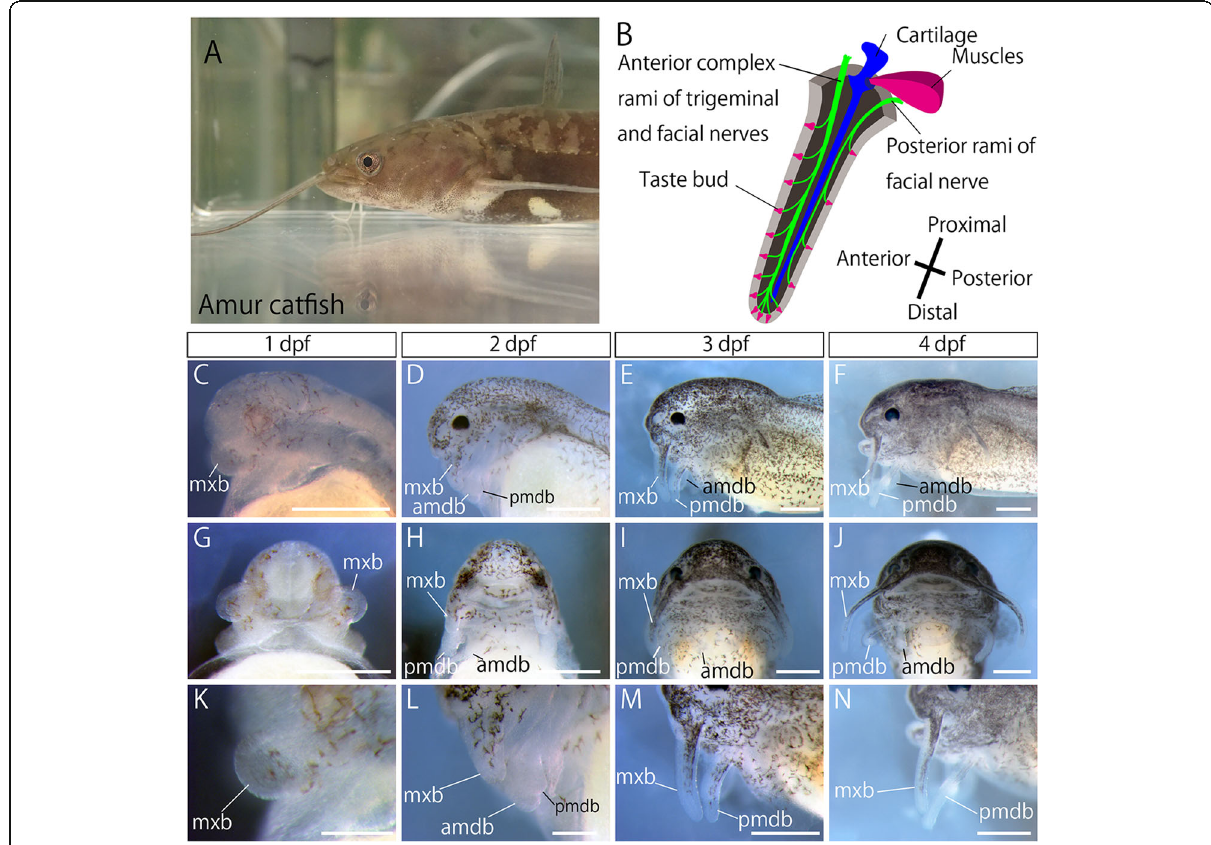
Fig. 1 Maxillary barbel and Craniofacial development of Amur catfish. a Lateral view of Amur catfish. b Schematic drawing of the maxillary barbel. This structure is composed of taste buds, blood vessels (not shown), cartilages, muscles, and peripheral nerves. The peripheral nerves include the anterior complex rami of trigeminal and facial nerves and posterior ramus of the facial nerve. Anterior is left and the proximal side is the upper side. Catfish embryos at 1 dpf ( c , g , k ), 2 dpf ( d , h , l ), 3 dpf ( e , i , m ), and 4 dpf ( f , j , n ) observed using optical macroscopy. Lateral views are shown in c – f and k – n . Ventral views are shown in g – j . amdb, anterior mandibular barbel; mxb, maxillary barbel; pmdb, posterior mandibular barbel. Scale bars in c – j , m , n are 500 μ m, and 200 μ m in i ,